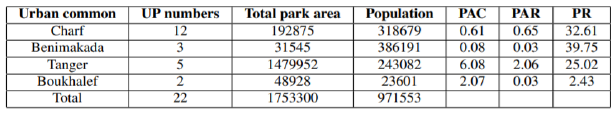
Table 3 . Up Numbers And Indices (Park Area Per Capita, Pac (in m2), Park Area Ratio, Par (in \%), Population Ratio, Pr